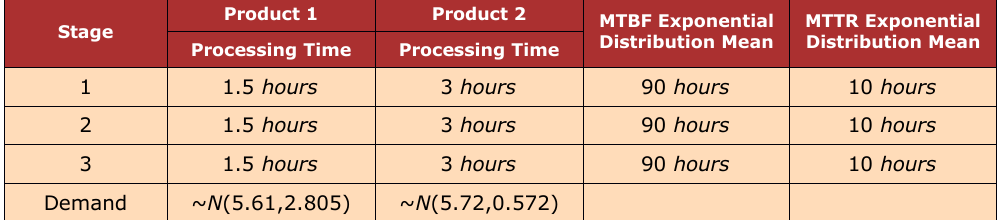
Table 1. Case-1 manufacturing system